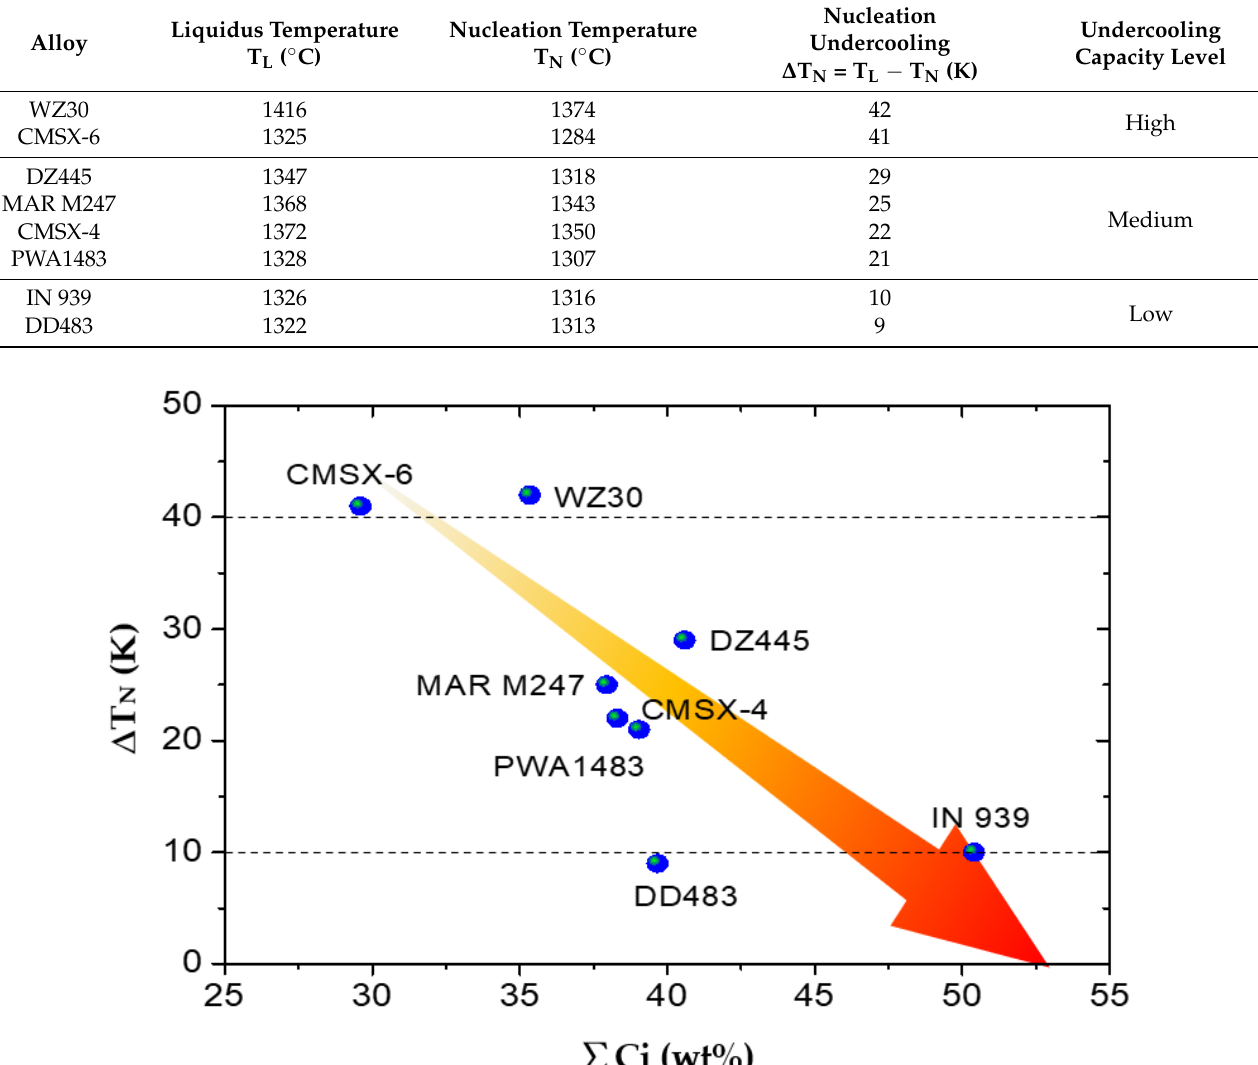
Table 2. The characteristic temperatures of the investigated superalloys, measured in the undercool- ing experiments.